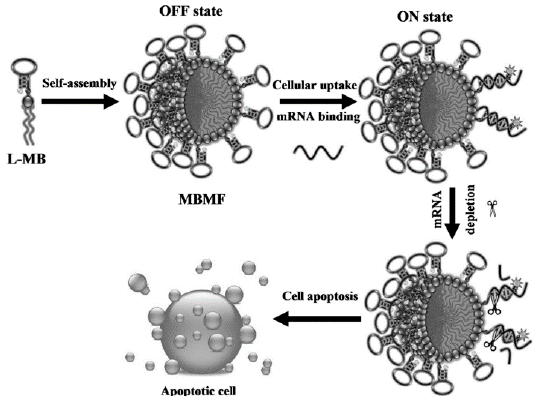
Figure 10. Schematic illustration of DNA nanohydrogels incorporating aptamers for effective targeted gene therapy. Reprinted with permission from © (2015) American Chemical Society [72].